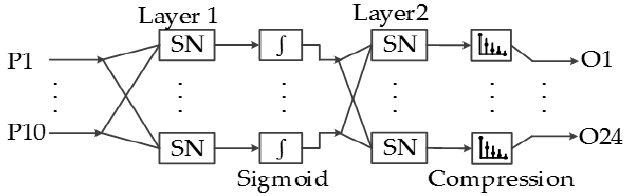
Figure 17. Implemented Artificial Neural Network architecture.